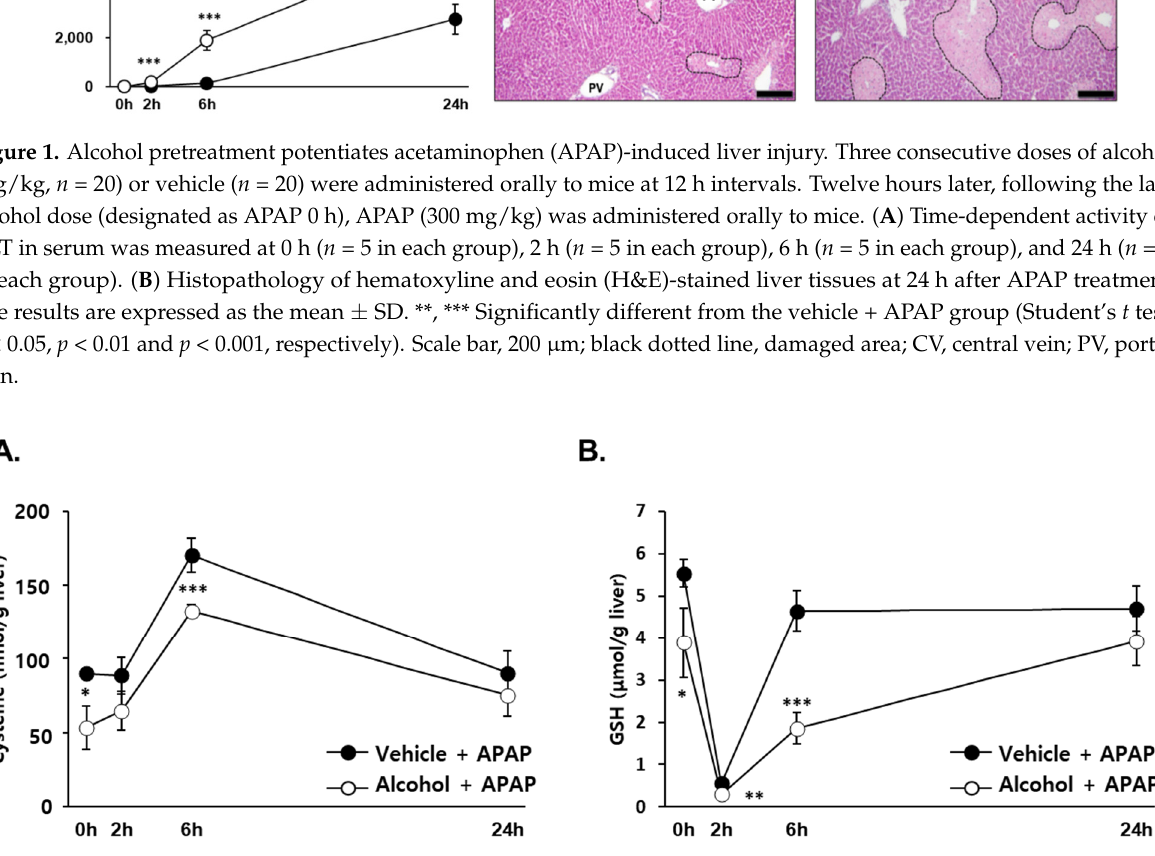
Figure 2. APAP pretreatment with alcohol changed cysteine, GSH concentration in the liver of mice. Three consecutive doses of alcohol (5 g/kg, n = 20) or vehicle ( n = 20) were administered orally to mice at 12 h intervals. Twelve hours later, following the last alcohol dose (designated as APAP 0 h), APAP (300 mg/kg) was administered orally to mice. The mice were euthanized at 0 h ( n = 5 in each group), 2 h ( n = 5 in each group), 6 h ( n = 5 in each group), and 24 h ( n = 5 in each group) after APAP administration. Time-dependent levels of ( A ) hepatic cysteine and ( B ) GSH. The results are expressed as the mean ± SD. *, **, *** Significantly different from the vehicle + APAP groups (Student’s t test, p < 0.05, p < 0.01 and p < 0.001, respectively).